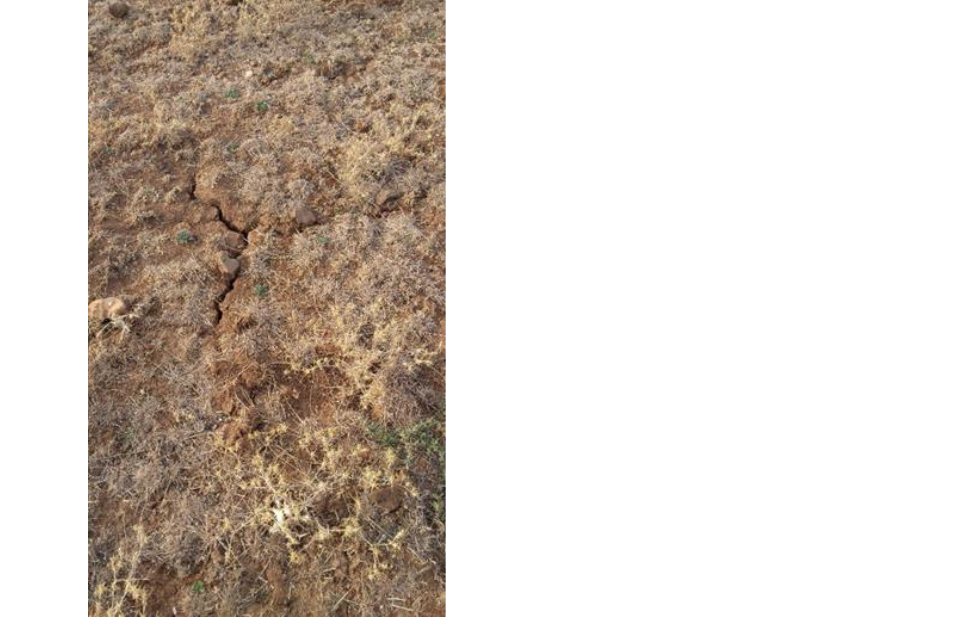
Figure 5. Characteristic crevices and cracks are formed in the ground due to summer dryness (© IL).